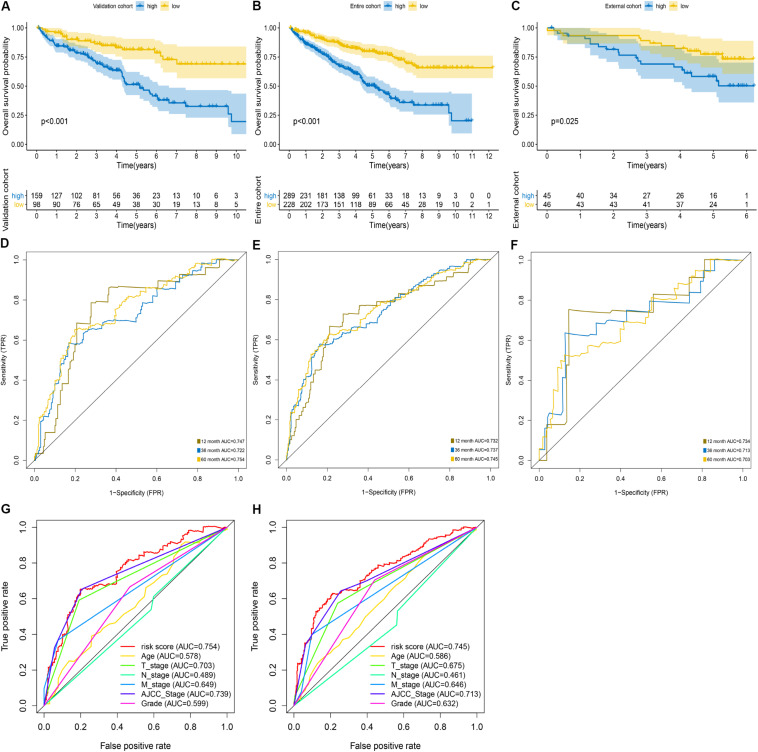
Validation of mRNASig. ICGC cohort was regarded as the external validation set. Kaplan–Meier analysis of mRNASig in internal validation cohort (A), the entire cohort (B), and external validation cohort (C). Time-dependent ROC analysis of mRNASig in internal validation cohort (D), the entire cohort (E), and external validation cohort (F). Comparison of the predictive power among risk score, age, AJCC-stage, T-stage, N-stage, M-stage, and grade in internal validation cohort (G) and the entire cohort (H).